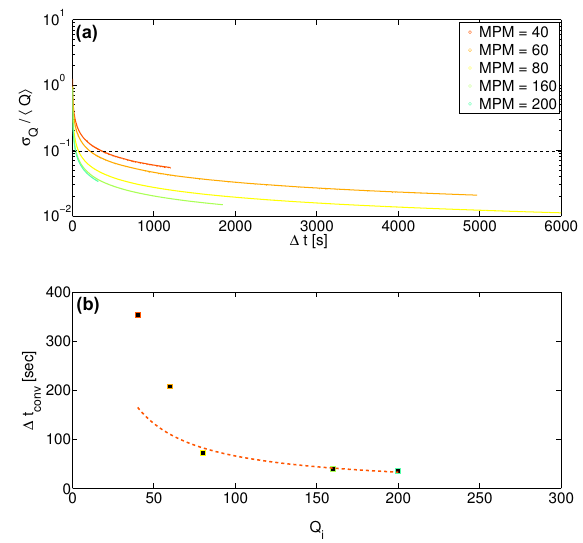
Figure 5. Determination of convergence time for experiments at all driving rates. (a) Standard deviation of an ensemble of samples over a given (cid:49)t . As (cid:49)t grows, the standard deviation decreases and approaches the threshold standard deviation. This value of (cid:49)t is interpreted to be the convergence time t conv . The standard deviation is normalized by the mean emigration rate Q . The legend indicates the feed rate in marbles per minute (MPM). (b) The time (cid:49)t conv necessary for flux measurements to converge to a threshold standard deviation of 10%, as a function of the driving frequency in number of marbles per minute. The dotted markers are the actual observed convergence times, while the dashed red line displays the trend that one would expect the convergence time to take if it were simply a function of the feed frequency ( (cid:49)t conv = 110 /f input ; see text for